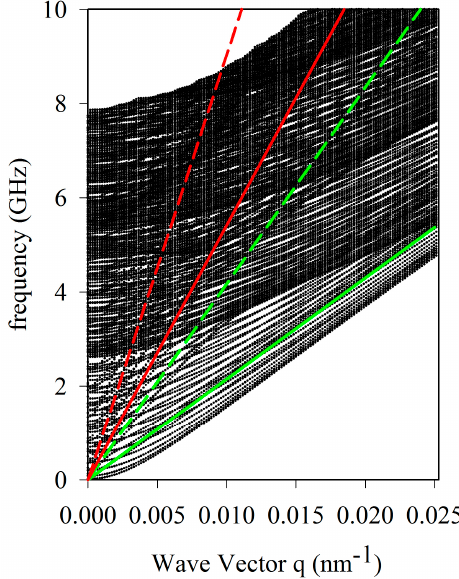
Figure 2. Dispersion curves calculation for the direction parallel to the nanoridges, limited to the 300 first eigenmodes for the set of geometrical parameters: a = 630 nm, h = 2.7 µm and w = 250 nm. The red (green) dashed and solid lines correspond respectively to the longitudinal and transverse velocities of the glass (epoxy).